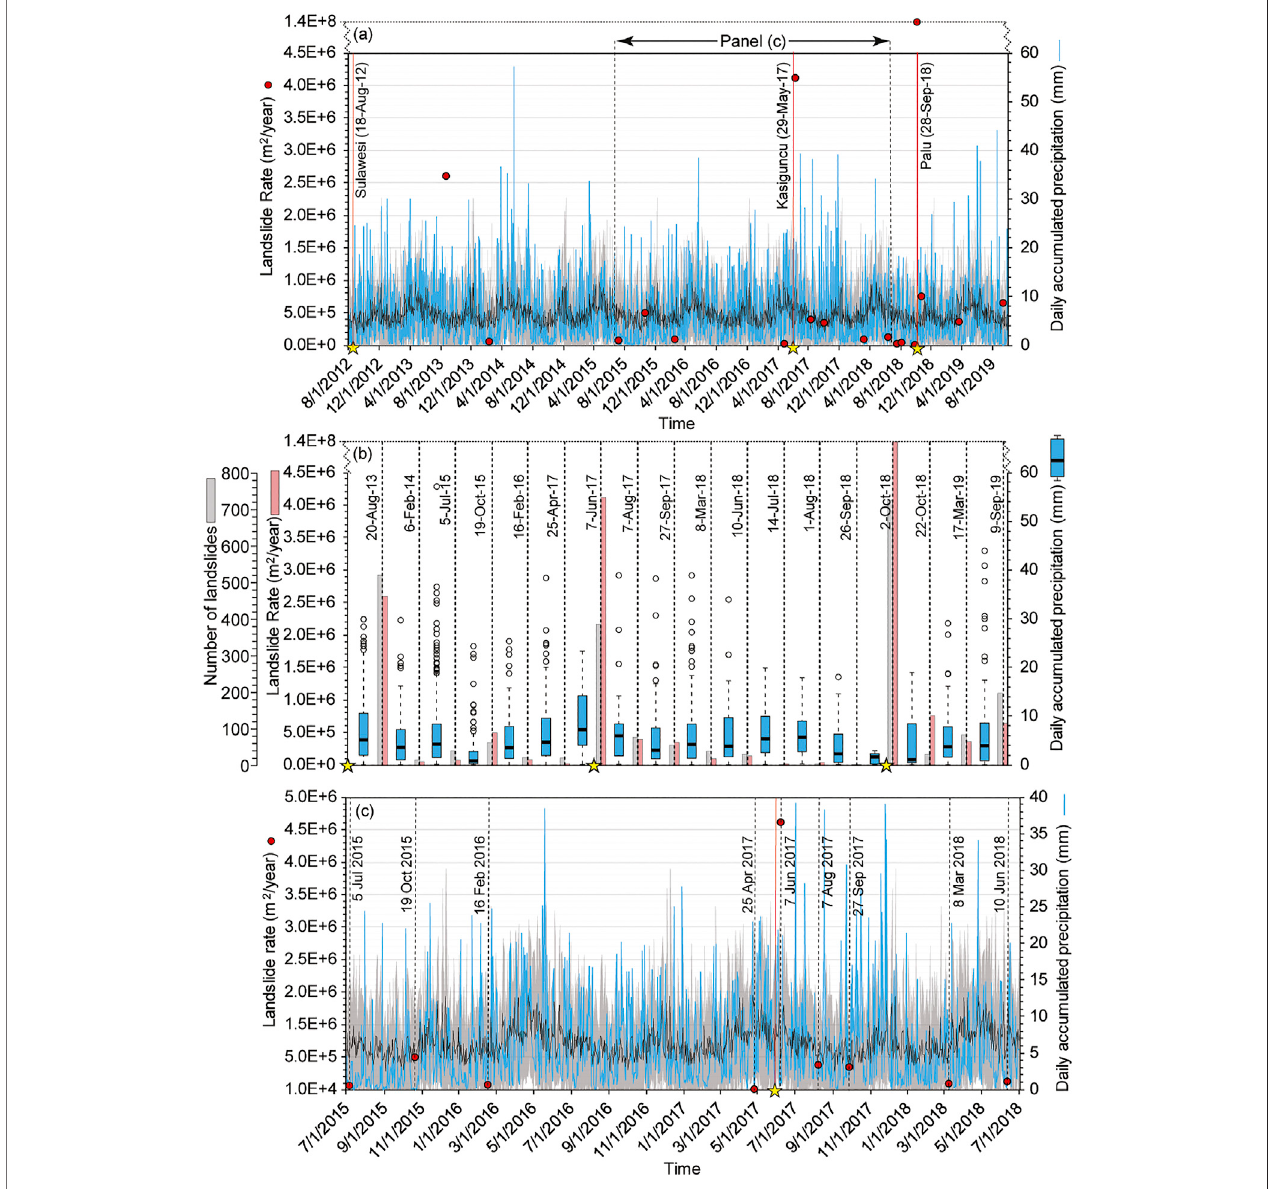
FIGURE 7 | Landslide rates, number of landslides and daily precipitation regarding (A – B) the largest time-window where we examined the landslides associated with three earthquakes (2012 Sulawesi, 2017 Kasiguncu and 2018 Palu earthquakes) and (C) a zoomed-in view plotted for pre-, co- and post-seismic landslides associated with the 2017 Kasiguncu earthquake. Yellow stars show the date of the earthquakes. Vertical dashed black lines indicate the dates of the satellite imagery used for mapping. In Panels A and C , the mean and standard deviation of daily accumulated precipitation is calculated from a 20-years time series are shown by black and gray lines, respectively. In Panel B , boxplots show minimum, median and maximum precipitation amounts as well as fi rst, third quartiles and outliers.